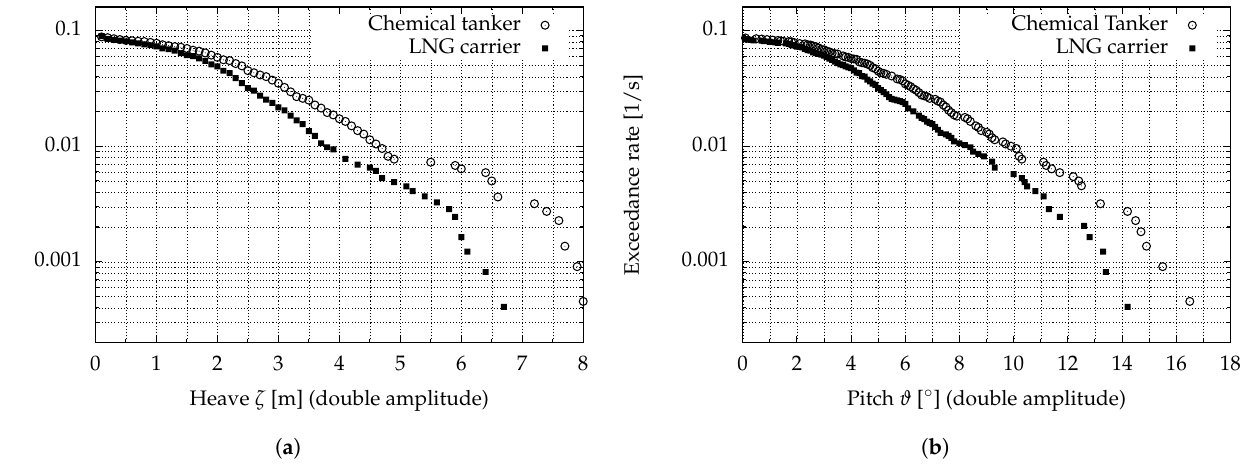
Figure 26. Chemical tanker vs. LNG carrier: short-term statistics of ( a ) heave and ( b ) pitch motions, model test results. Containership Short-term statistics were obtained for the containership in irregular sea states using field method and model tests. Range-pair counting yielded exceedance rates of ship responses both for the model tests and the field method numerical simulations. Computed and measured motions and the normalized vertical bending moments are compared. Heave and pitch motions agree satisfyingly, see Figure 27. The selected ranges for the horizontal axes equal those from the chemical tanker and the LNG carrier. Figure 28 plots the exceedance rates of midship vertical bending moment amplitudes. To eliminate the high-frequency vibratory part from the time histories, the response was low-pass filtered with a cut-off frequency of 0.25 Hz. The remainder was assumed to correspond to the rigid-body midship vertical bending